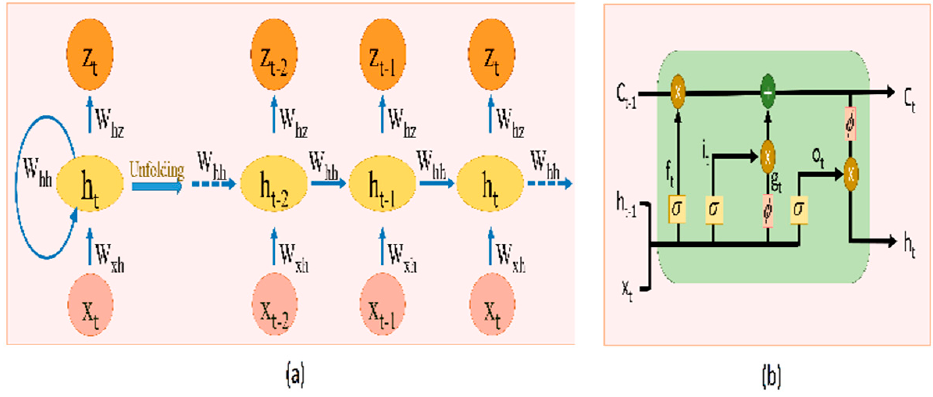
Figure 1. ( a ) Unfolded version of basic RNN; ( b ) LSTM module.